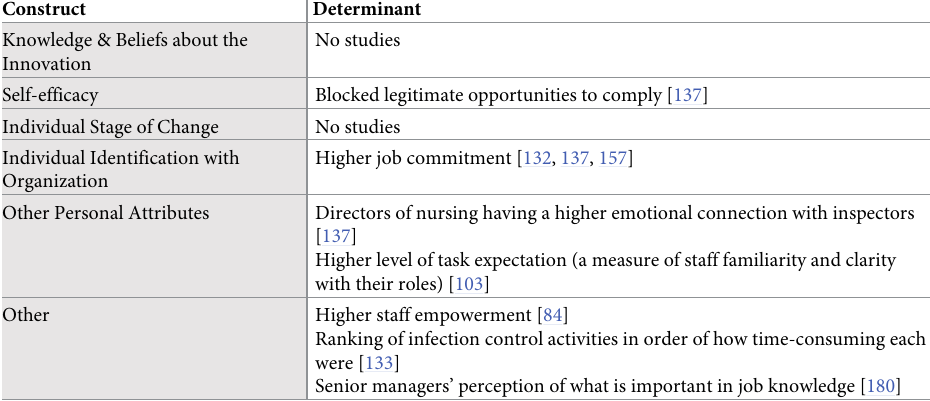
Table 5. Determinants coded to the characteristics of individuals